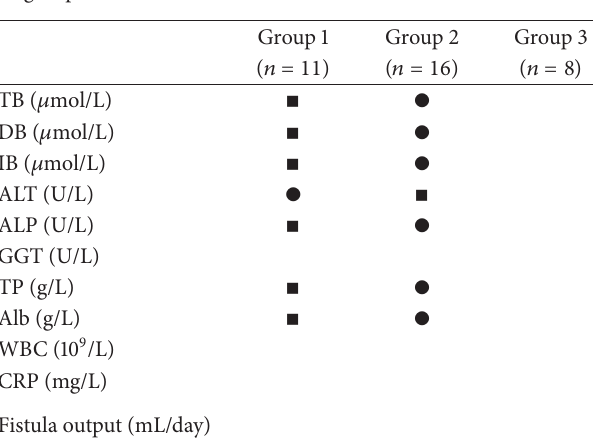
Table 5: Comparison of therapeutic efficacy in the fistuloclysis